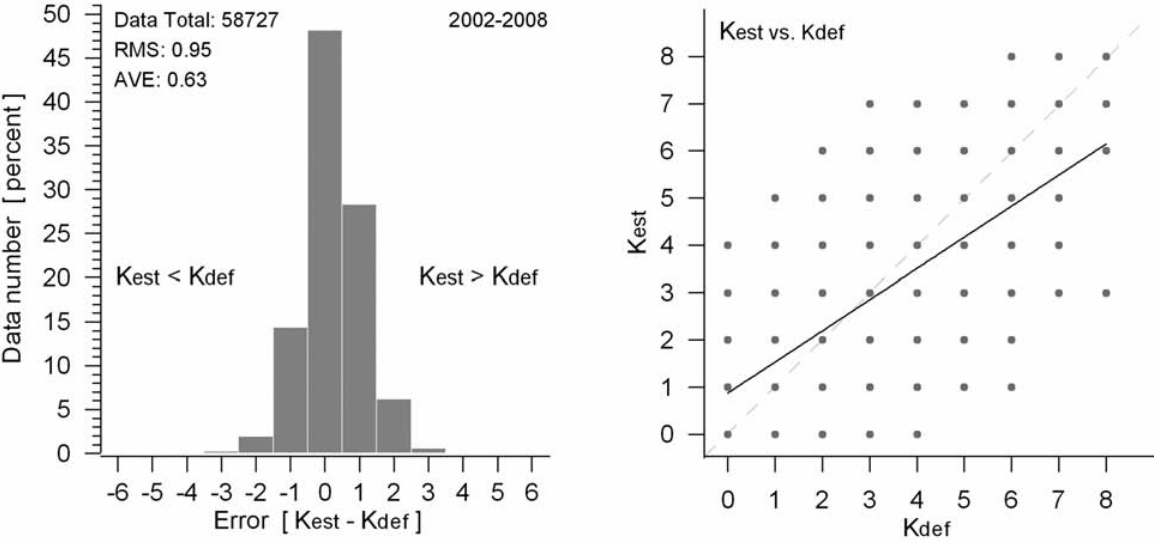
Figure 6. Evaluation of the K index nowcast for the period 2002-2008, for Dourbes. Left: Histogram of residual errors, as Kest minus Kdef. Right: Scatter plot of Kest versus Kdef.